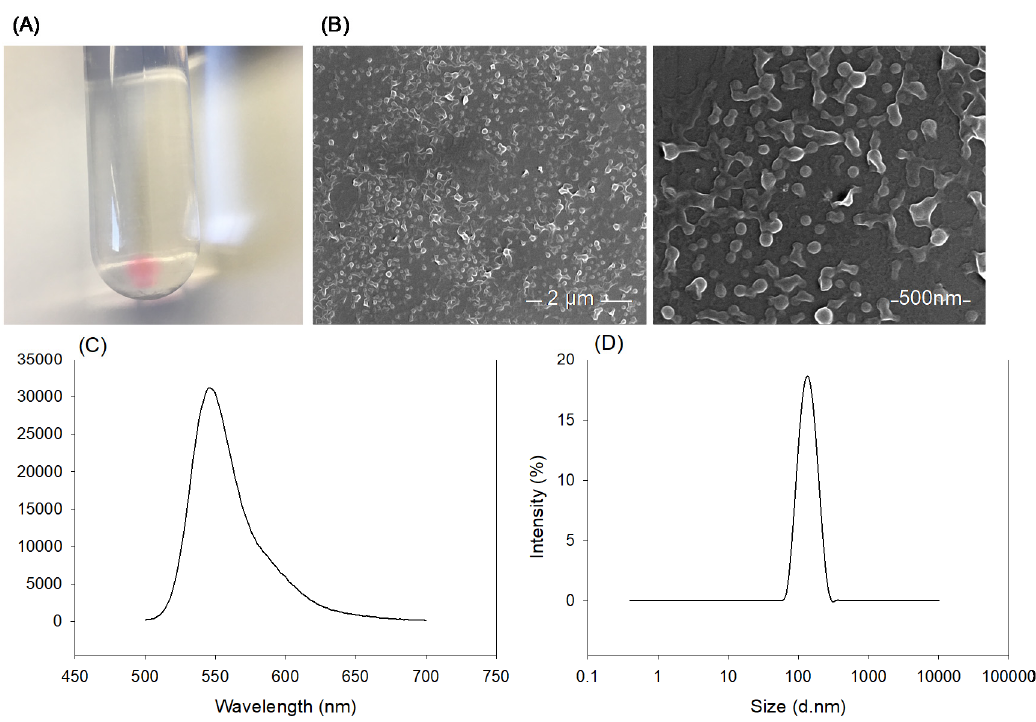
Figure 7. ( A ) Image of Rhodamine 6G-loaded PLGA NPs upon centrifugation, confirming their loading with the dye. ( B ) SEM images, ( C , D ) fluorescence spectrum ( λ EX = 480 nm), and size distribution of Rhodamine 6G-loaded PLGA NPs.